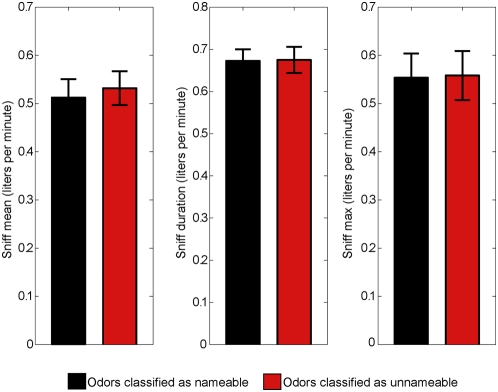
Sniff size across conditions.Participants sniffed equally during nameable and unnameable conditions. The left panel shows the mean sniff, in liters per minute, for nameable and unnameable conditions. The center panel shows sniff duration, in liters per minute, for nameable and unnameable conditions. The right panel shows sniff maximum, in liters per minute, for nameable and unnameable conditions.